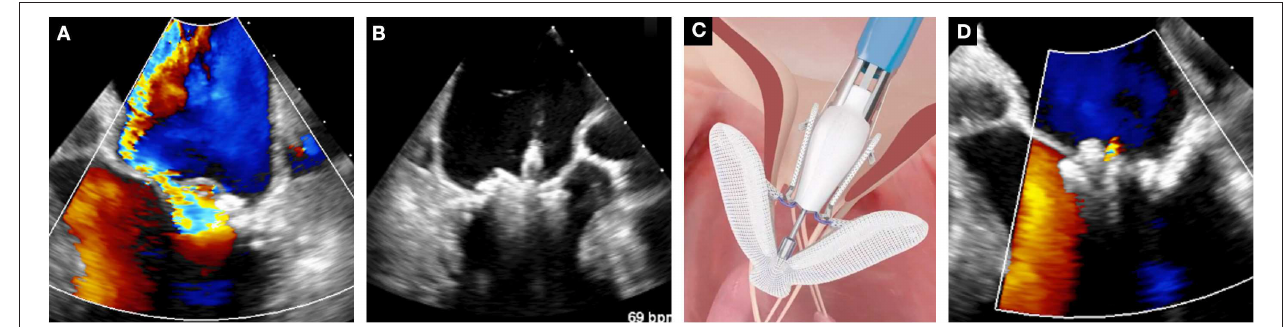
FIGURE 1 | Case of leaflet approximation with PASCAL device in secondary MR. (A) Baseline color-Doppler echocardiographic assessment of MR. (B) Leaflet clasping. (C) Schematic depiction of the PASCAL system (courtesy of Edwards Lifesciences). (D) Assessment of the final result with color Doppler echocardiography.